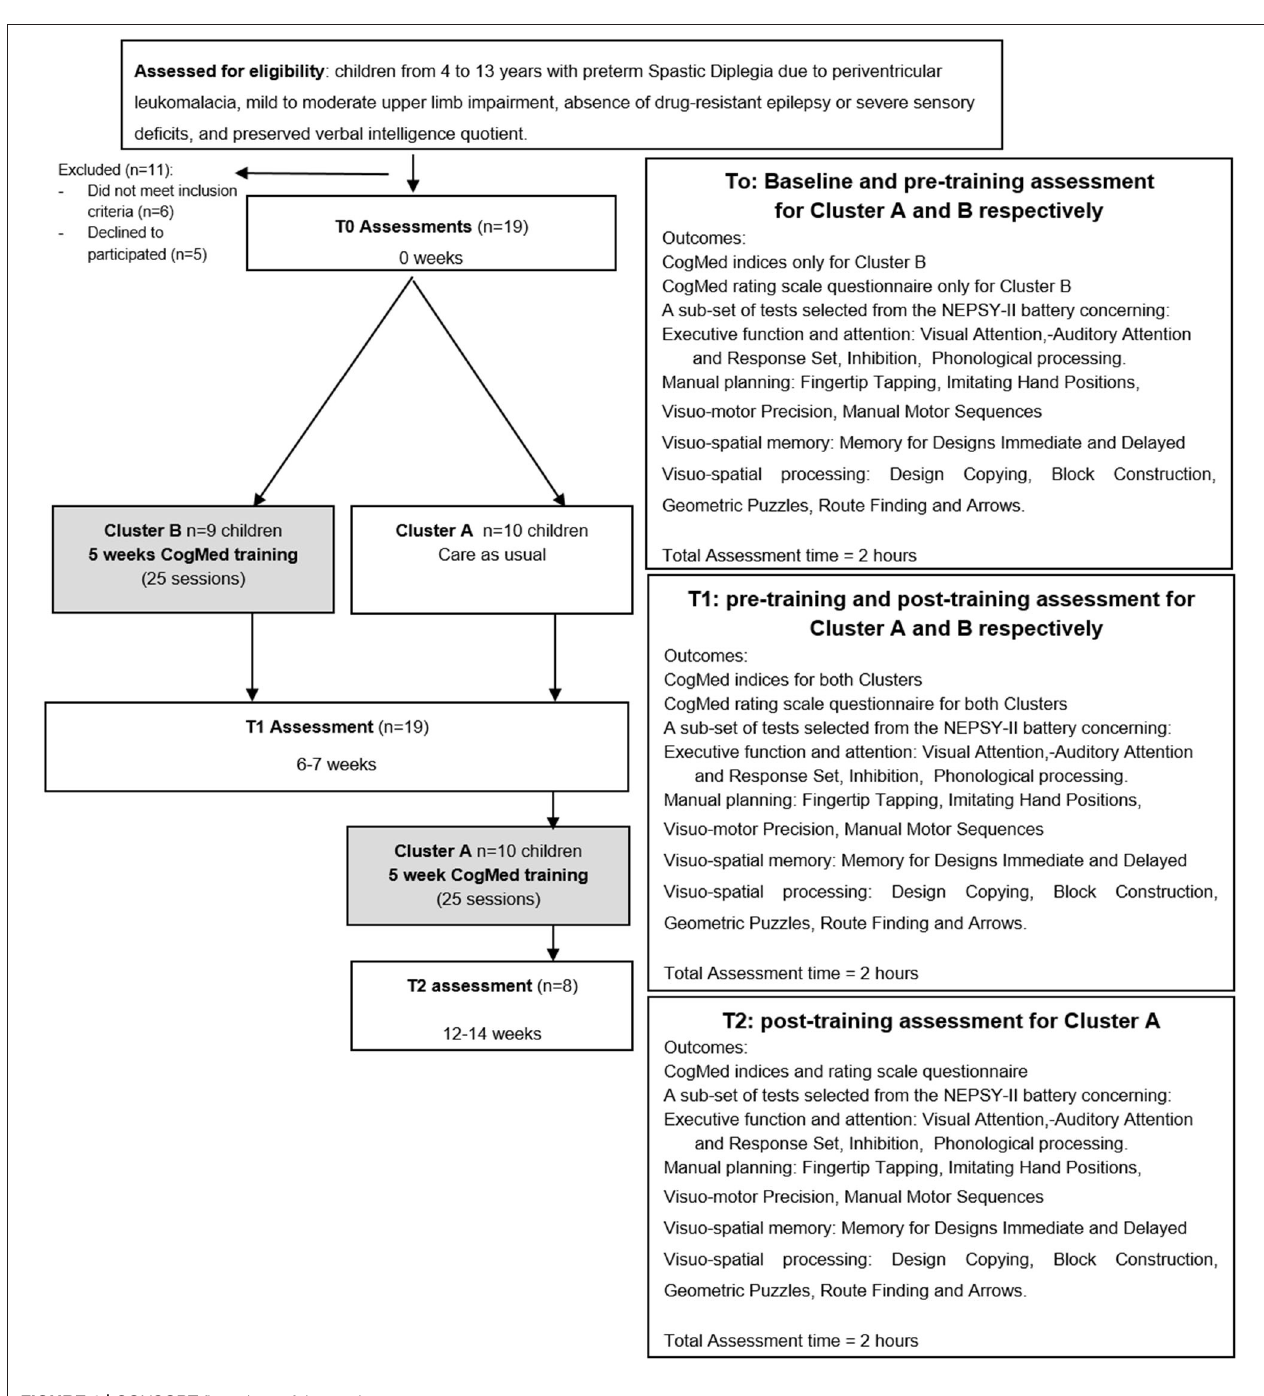
FIGURE 1 | CONSORT flow chart of the study.